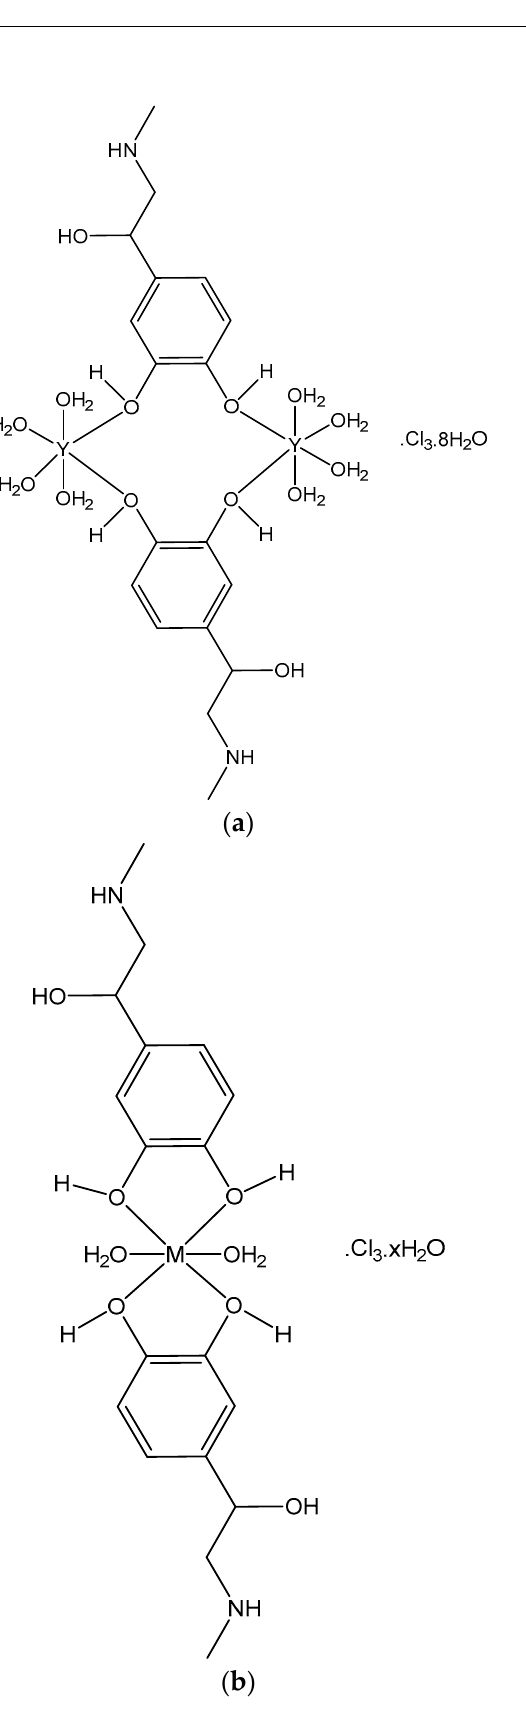
Figure 1. ( a ): Suggested structures of [Y 2 (Adr) 2 (H 2 O) 8 ]Cl 3 · 8H 2 O adduct. ( b ): Suggested structures of [Ce(Adr) 2 (H 2 O) 2 ]Cl 3 · 10H 2 O, [Nd(Adr) 2 (H 2 O) 2 ]Cl 3 · 6H 2 O and [Sm(Adr) 2 (H 2 O) 2 ]Cl 3 · 12H 2 O ad- ducts.